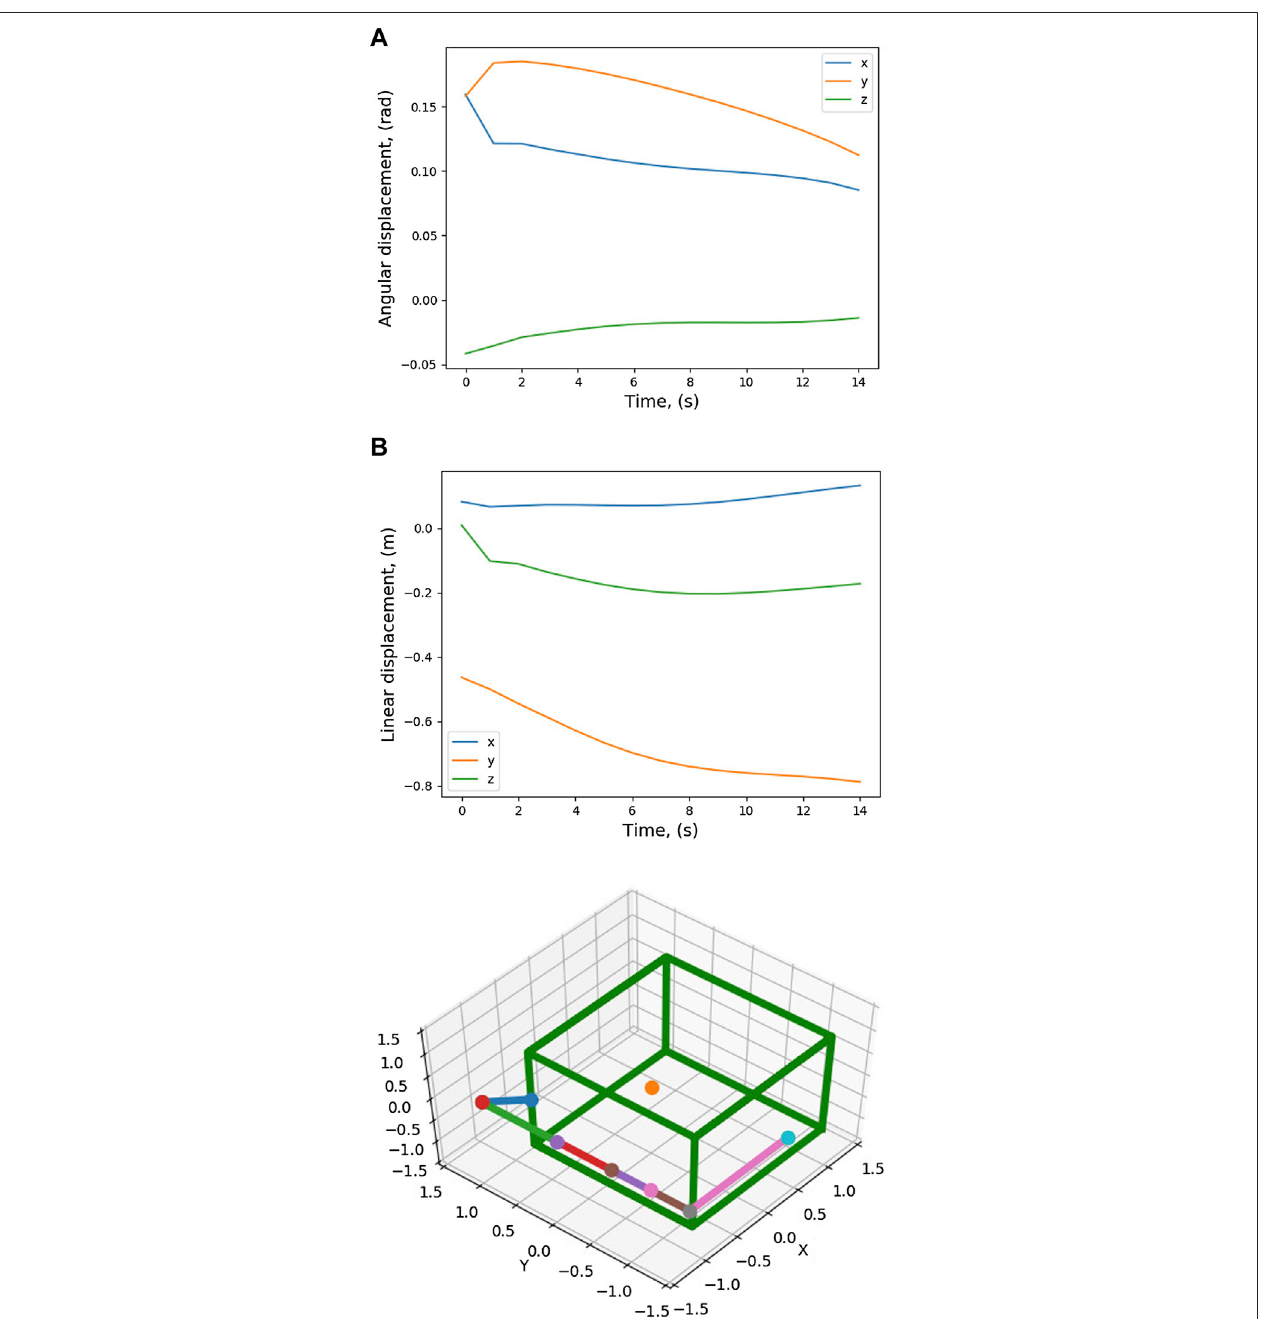
FIGURE 7 | Pose variation of the spacecraft CG during trajectory